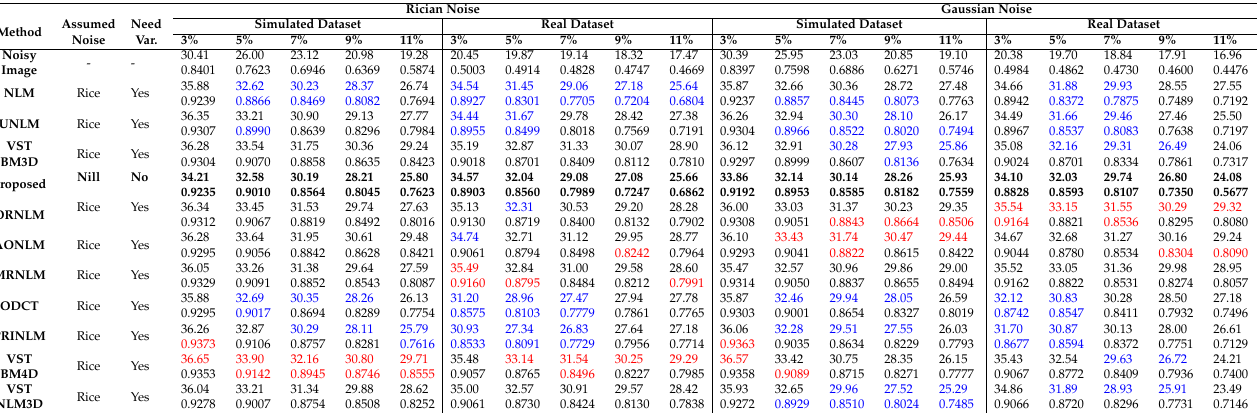
Table 1. Quantitative comparison (peak signal to noise ratio (PSNR) and structural similarity index (SSIM) values) of the proposed denoising approach with existing approaches. Each row indicates a different method and each column indicates a different noise level (in % , i.e., 2% means noise variance is 255 × 0.02 = 5.1 for image with 255 maximum intensity value) with mentioned distribution (Rician/Gaussian) and mentioned datasets (real/simulated